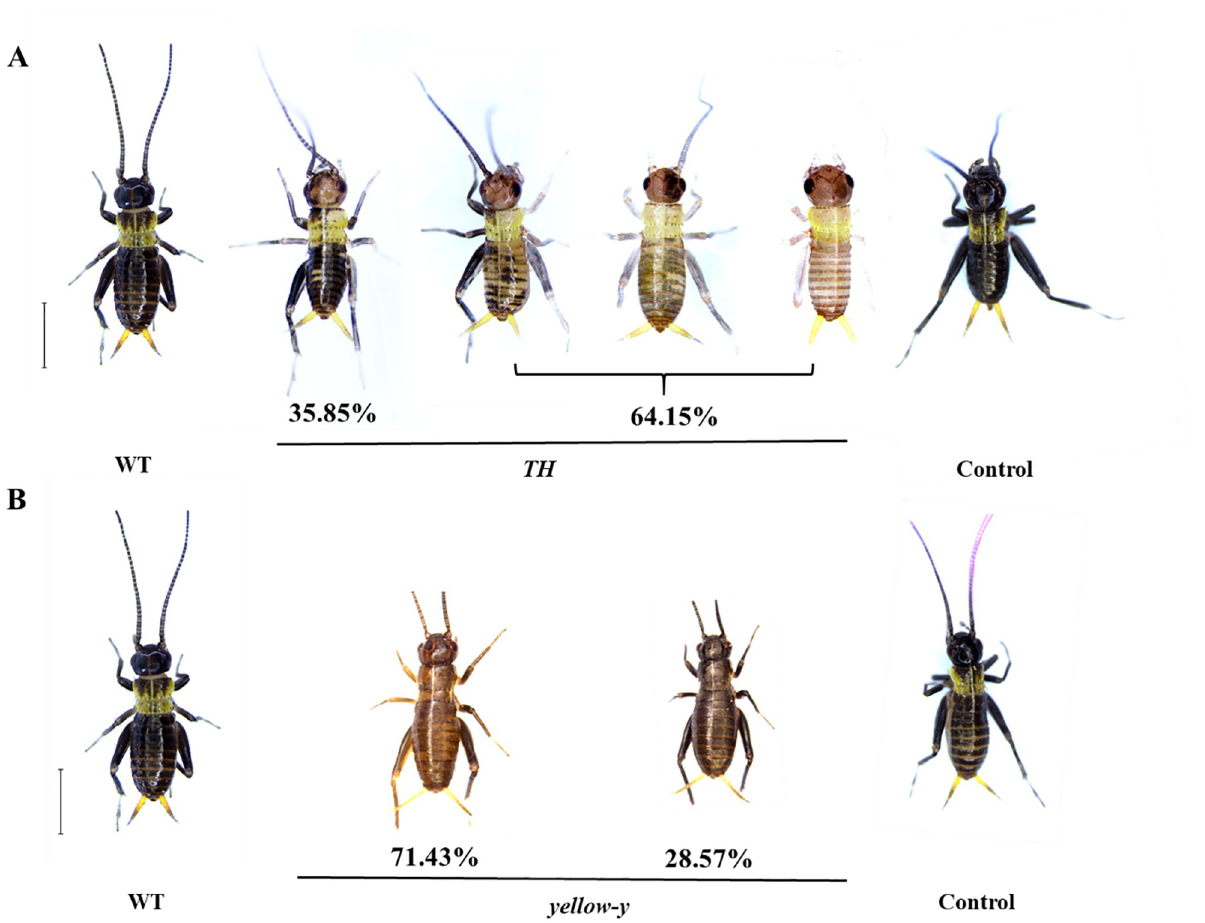
Fig 5. Phenotypic analysis. (A) Phenotypes of dysfunction TH in G . bimaculatus . The WT was observed on the 5th-day of 1st larval instar. (B) Phenotypes of dysfunction yellow-y in G . bimaculatus . The WT was observed on the 5th-day of 1st larval instar. The mutants are brown mosaic. Control represents an individual injected with Cas9 protein only. Bar =